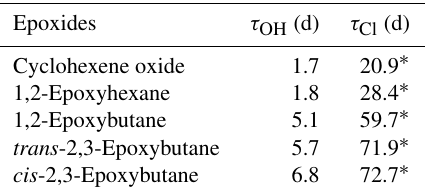
Table 5. Comparison of the atmospheric lifetimes of epoxides to- wards OH radicals and chlorine atoms. Epoxides τ OH (d) τ Cl (d) Cyclohexene oxide 1.7 1,2-Epoxyhexane